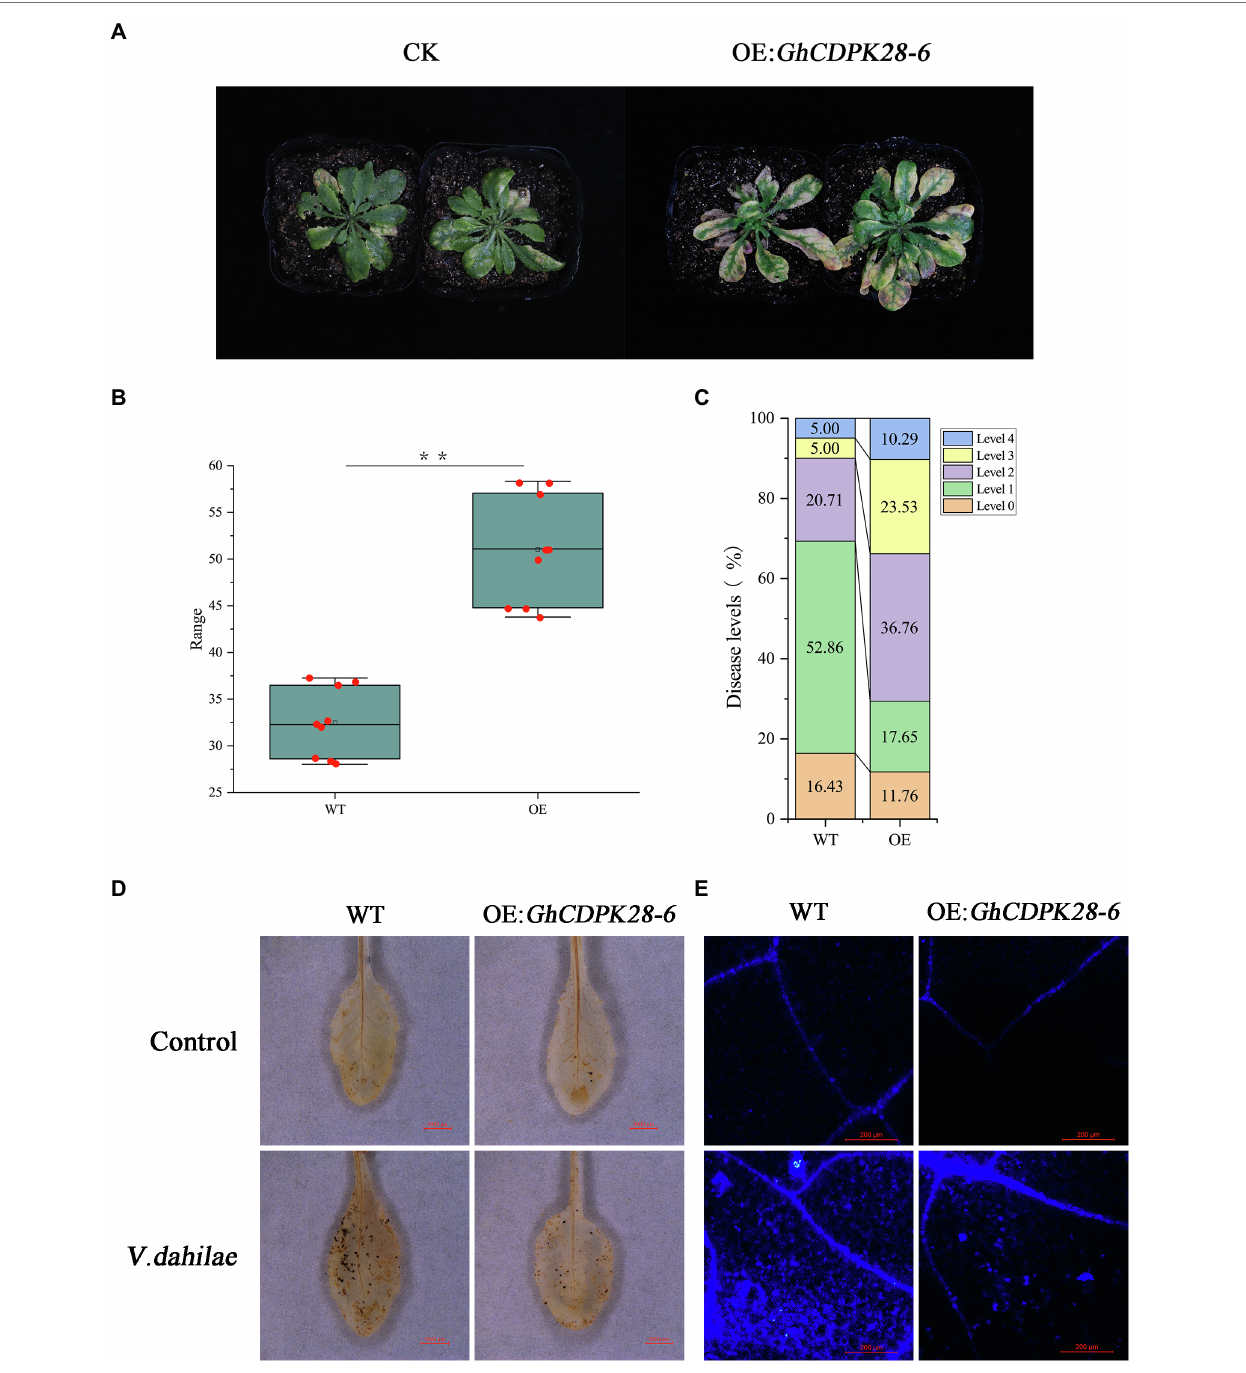
FIGURE 8 | Overexpression of GhCDPK28-6 in A. thaliana attenuated its resistance to V. dahliae . (A) Phenotype of A. thaliana after vd080 inoculation in soil. (B,C) Disease index. (D) DAB staining was used to detect the production and accumulation of ROS in A. thaliana leaves at 12 h after inoculation. It was observed under the stereomicroscope with 10× amplification. The scale is 3,000 μ m. (E) Callose deposition in cotton leaves, the scale is 200 μ m. The error bar represents standard deviation of three biological replicates. Asterisks indicate statistically significant differences (** p < 0.001, Student’s t